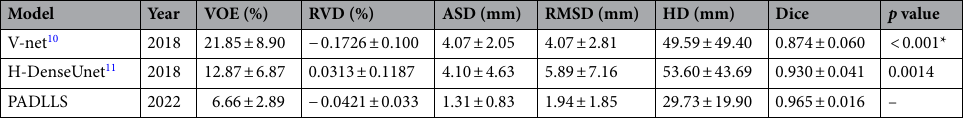
Table 2. Comparison of liver segmentation results on 3DIRCADb. An asterisk indicates a statistically significant difference in Dice score between our pipeline and another model ( p < 0.05).